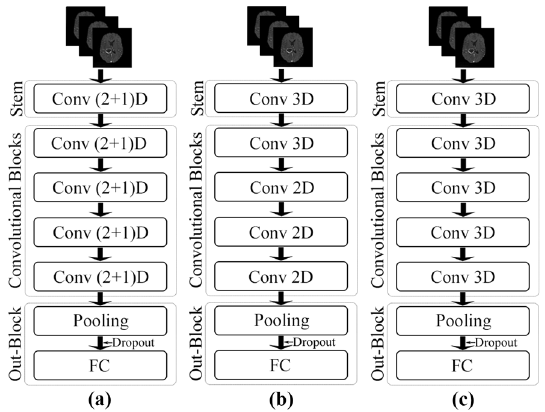
Figure 3. Schematic representations of the network architectures. ( a ) ResNet (2+1)D, ( b ) ResNet Mixed Convolution, and ( c ) ResNet